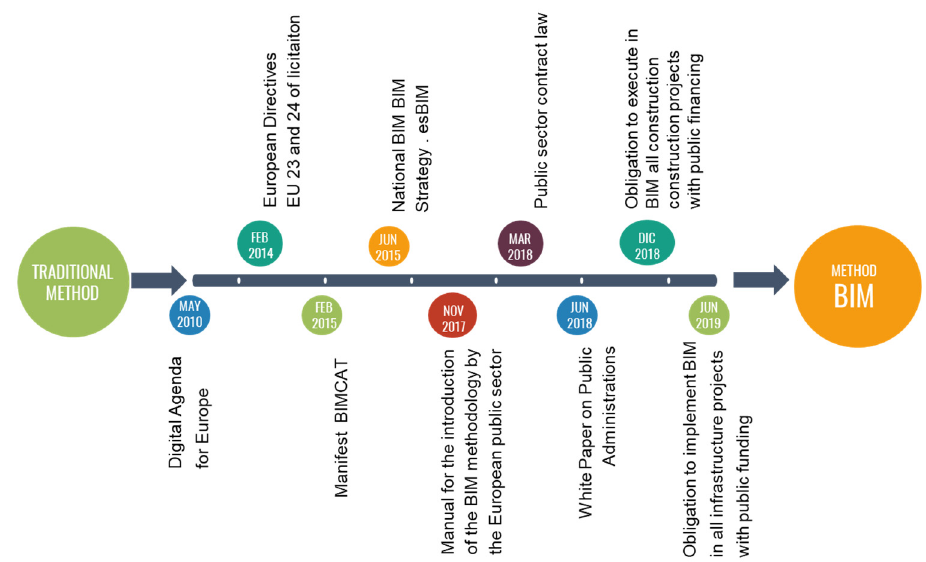
Figure 3. Timetable regarding the implementation of BIM in Spain.